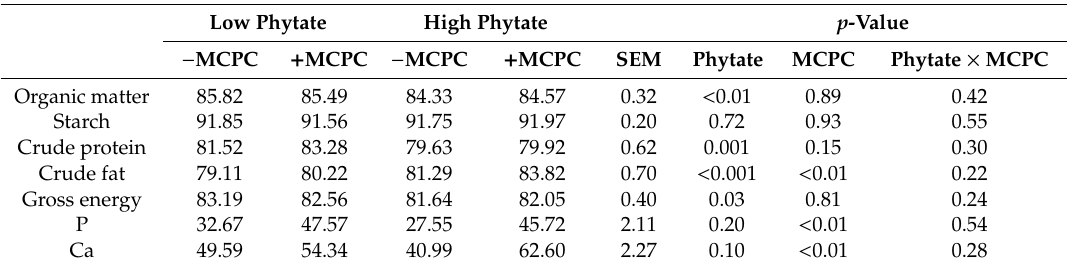
Table 3. E ff ects of phytate level and enzymes on the ATTD of nutrients 1